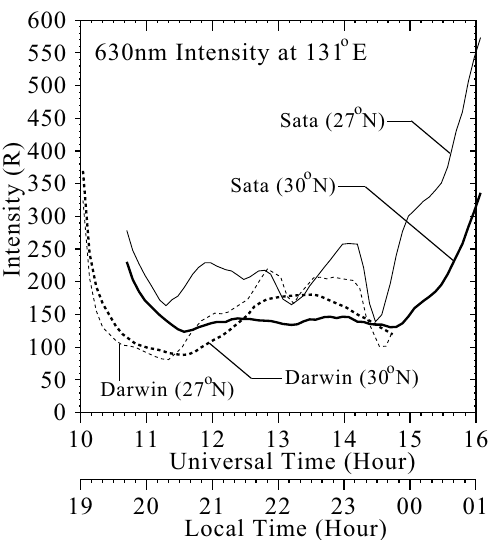
Fig. 6. Variation of nocturnal 630.0-nm airglow intensities at Sata and Darwin on 4 April 2002. The intensities were extracted from airglow images at Sata and Darwin at geographic locations of (27.0 ◦ N, 131.0 ◦ E) and (30.0 ◦ N, 131.0 ◦ E) in the Northern Hemi- sphere (Darwin images were converted to the Northern Hemisphere, as shown in Fig.